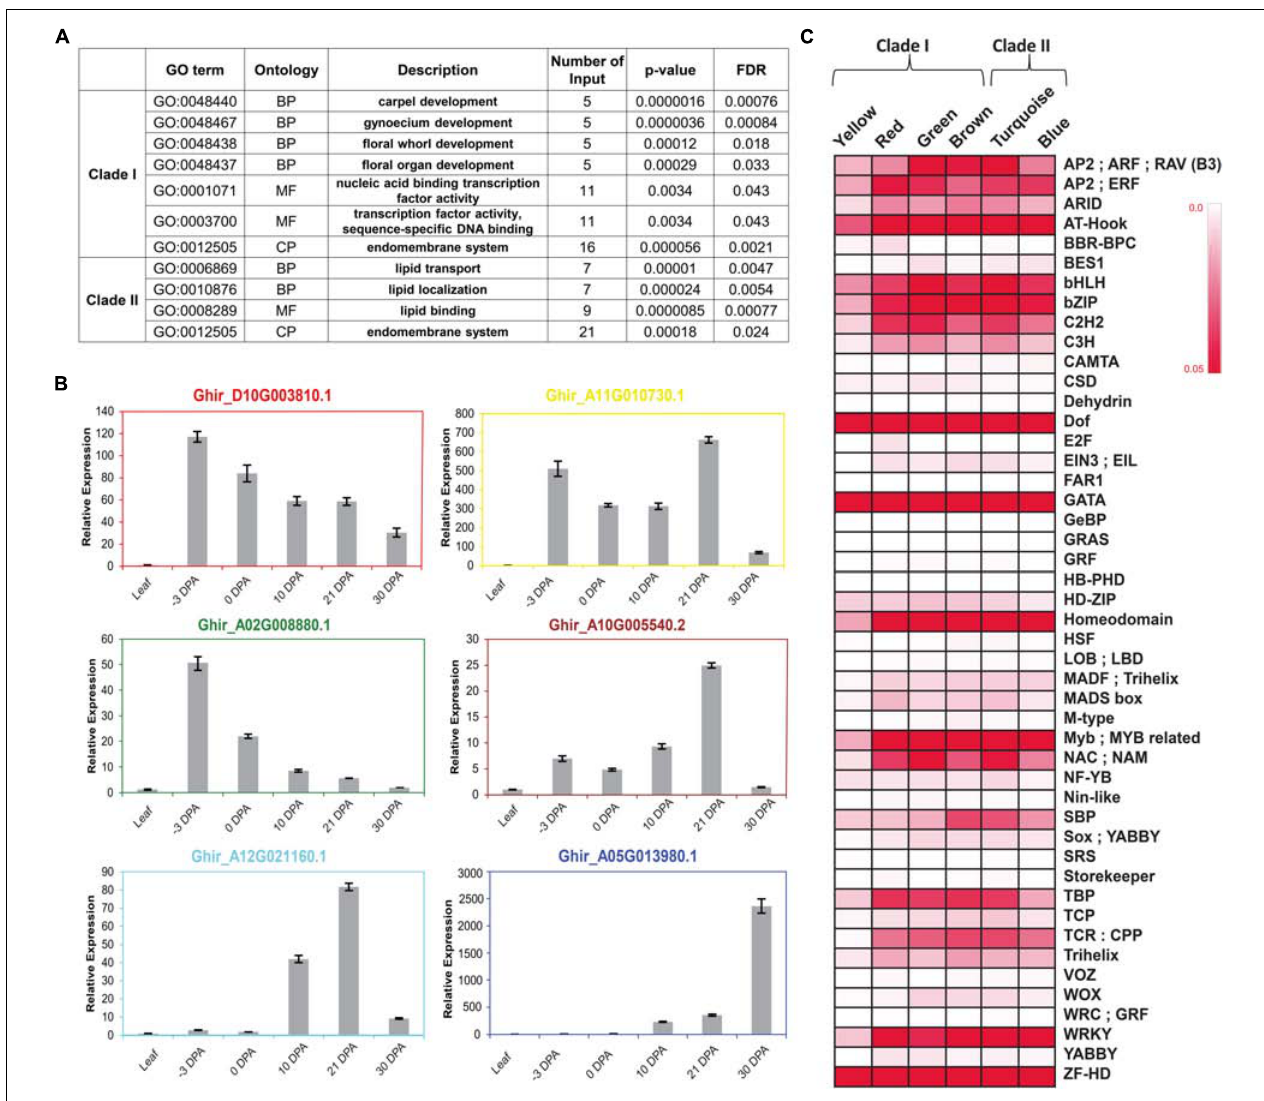
FIGURE 4 | Functional enrichment of each clustered module and clade. (A) Arabidopsis based significant gene ontology (GO) enrichment of two major clades, viz. , Clade I and Clade II. False Discovery Rate (FDR) value < 0.05 was used for checking the significance level of each GO Term. (B) Real-time expression analysis of hub gene of all six modules. Hub genes are the representative of each module that confirmed their expression behavior through real-time expression analyses in leaf tissues, –3 DPA, 0 DPA, 10 DPA, 21 DPA, and 30 DPA of fiber developmental stages. (C) Binding frequency of cis -regulatory elements in the promoter region of genes is present in all six modules, viz. , yellow, red, green, brown, turquoise, and blue. Color code ranges from 0 to 0.05; zero represents the lowest binding frequency of cis -regulatory element (CRE), while 0.05 depicted the higher binding frequency of CRE over the promoter